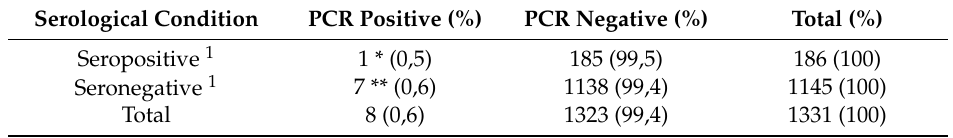
Table 3. Correlation between Vaccinia virus (VACV) DNA detection in blood samples by PCR test and detection of neutralizing antibodies in serum samples of the same sampled animals previously tested